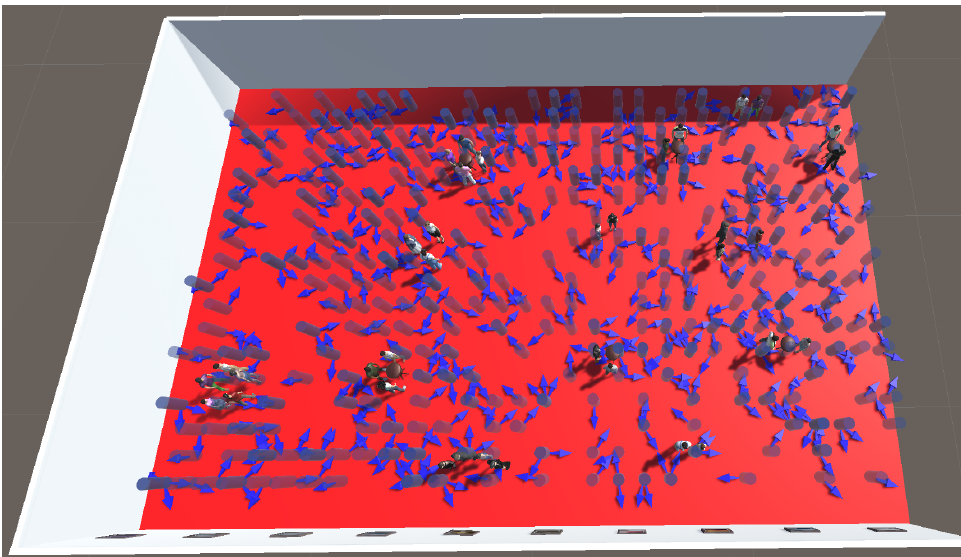
Figure 13. The global view of Scene 2, along with 500 randomly generated positions for the robot, which are represented by purple-coloured cylindrical spaces. The arrows represent the facing direction of the robot for respective position (best viewed in colour).